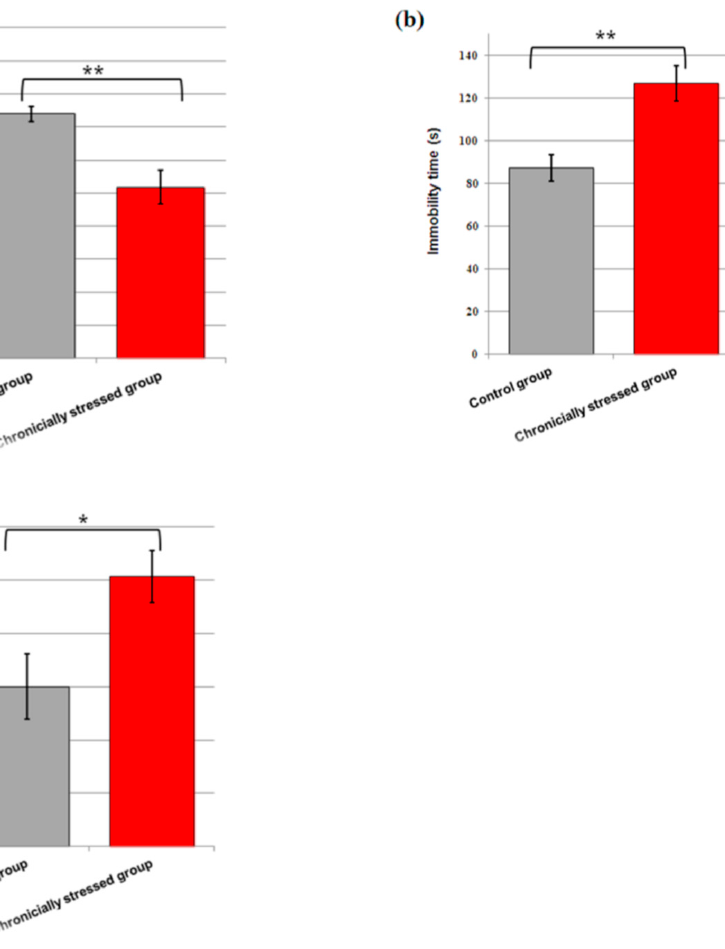
Figure 1. The effects of chronic (21-day) corticosterone injections for sucrose consumption in SPT ( a ), and immobility time in FST ( b ) and TST ( c ). All values are reported as mean ± SEM ( n = 8). Significance: * p ≤ 0.05, ** p < 0.01 vs. control group (Student’s t -test).